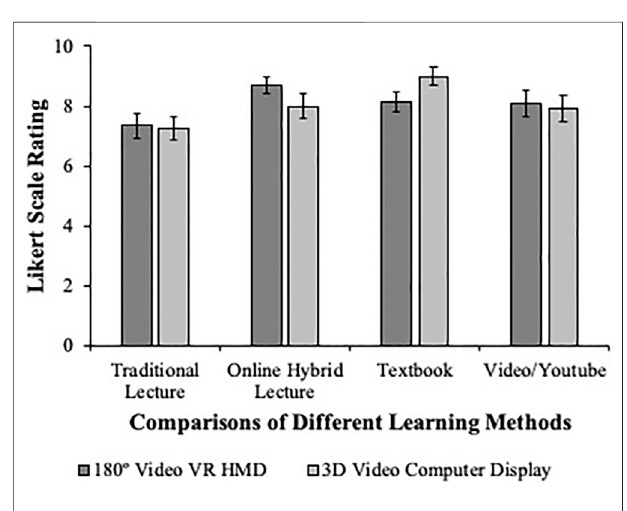
FIGURE 5 | Between-groups participants ’ reporting of the VR experiencecompared tootherlearningmethods.Thedatashow thatboth the 180 ° videoVRHMD(darkgraybars)andthe3Dvideocomputerdisplay(lightgray bars)experienceswerereportedwithequallyhighratingsbyparticipants,but they did not differ signi fi cantly from one another. However, the overall fi nding was that the students equally preferred the 180 ° video VR HMD and the 3D